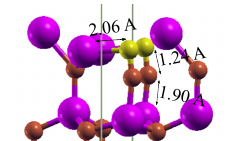
Figure 4. The most stable adsorption site in the case of 0.5 ML.